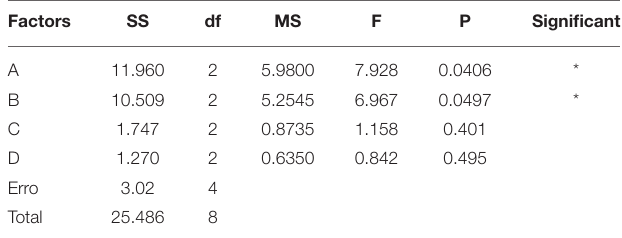
TABLE 3 | Analysis of variance of orthogonal